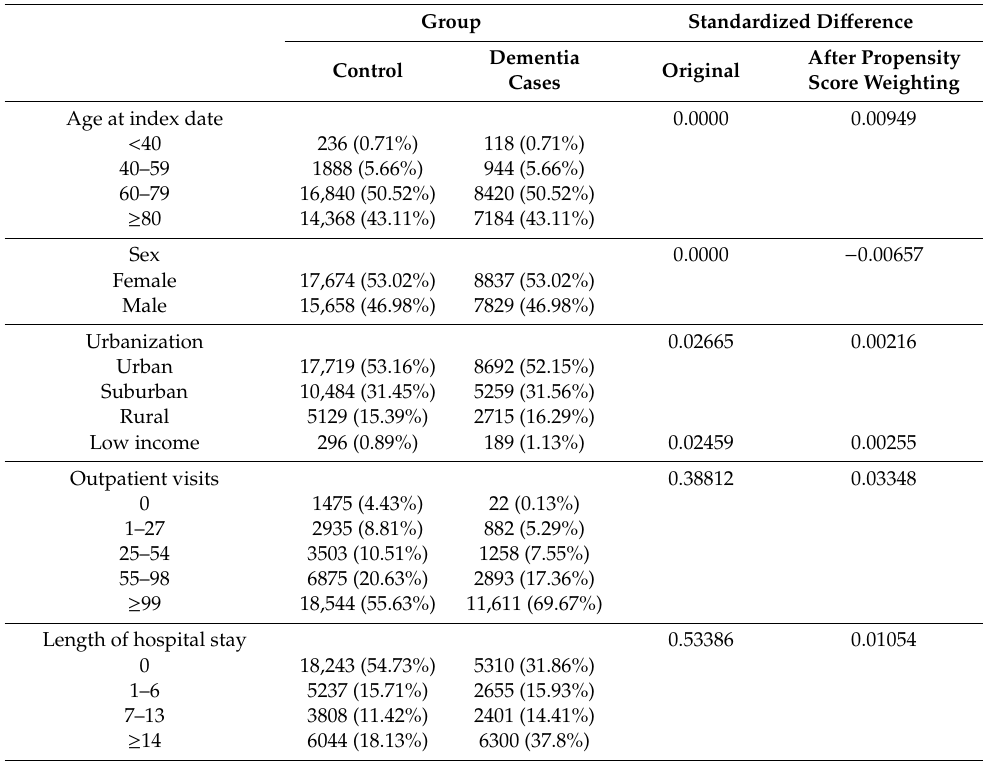
Table 1. Characteristics among